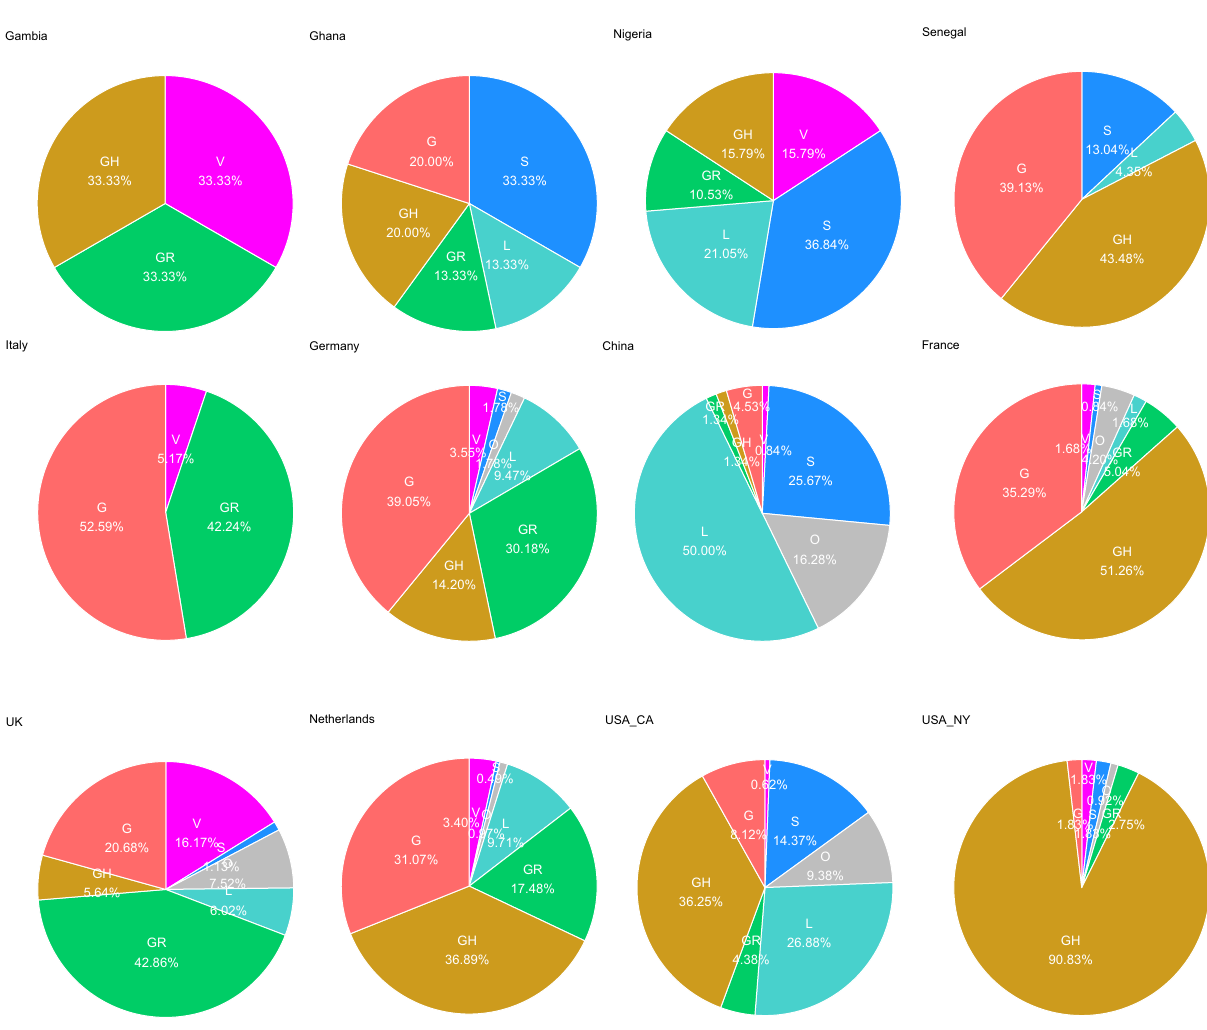
Figure 4. West African countries display distinct patterns of China-and Europe-based clades (until April 2020). Nigeria has the highest percentage of the China-based early clades (L, S, V) and Ghana has nearly equally distributed percentages of China and Europe-based clades (G, GH, GR). Senegal has a similar clade distribution as France but also a few samples from the early China-based clades. In Gambia there were only three sequences, two from Europe-based clades GR and GH and one from China-based clade V. The charts were generated using R (version 3.6.1, https:// www.r- proje ct. org/), [Ihaka, R. & Gentleman, R. R: A language for data analysis and graphics. J. Comput. Graph. Stat . 5 , 299–314 (1996)] and the R package ggplot2 (version 3.3.0, https:// ggplo t2. tidyv erse. org/), [Wickham, H. Ggplot2: Elegant Graphics for Data Analysis . (Springer,